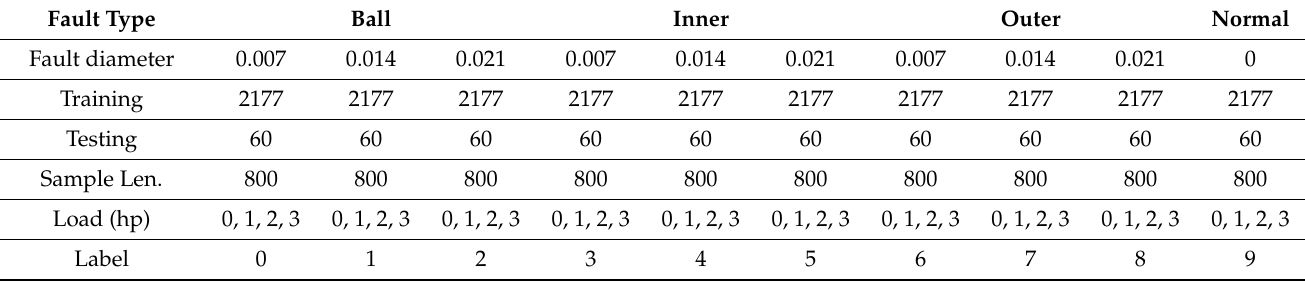
Table 2. Dataset